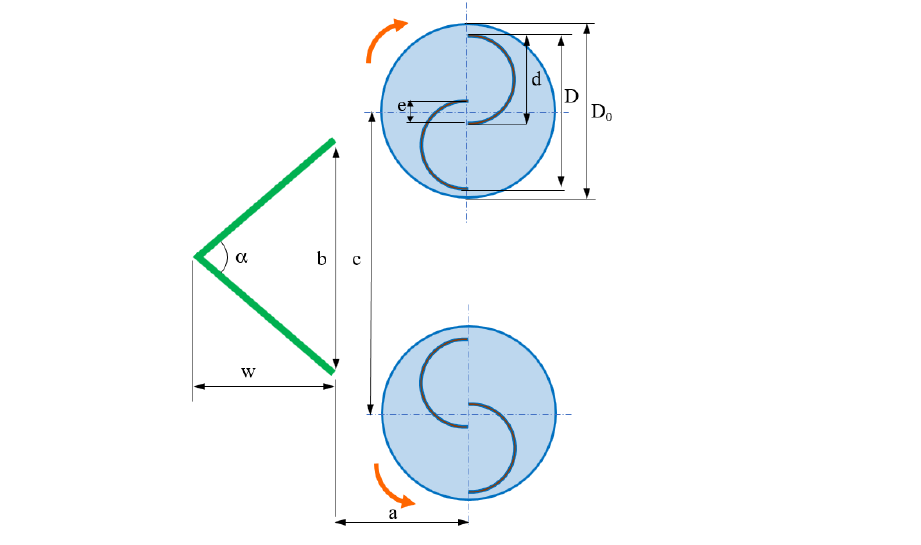
Figure 6. Geometric parameters of dual turbine design with triangular plate.